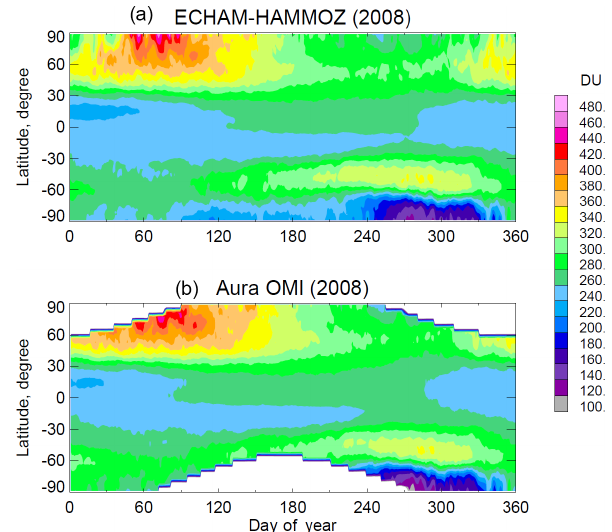
Figure 2. Comparison of the seasonal cycle of zonal mean total column ozone (in DU) between ECHAM-HAMMOZ (a) and Aura OMI (b) . Data and model are for the year 2008. Aura OMI data were interpolated to model